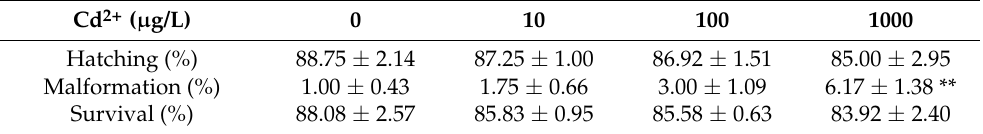
Table 2. The changes in hatching, malformation, and survival rates in zebrafish embryos/larvae treated with Cd 2+ and Hg 2+